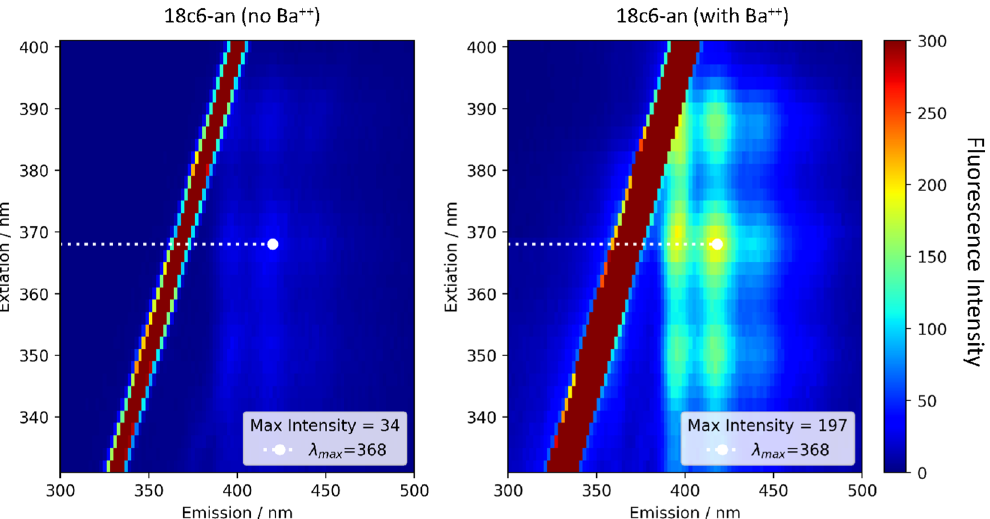
Figure 11. Fluorescence response of 18c6-an shown as a function of emission and excitation. The diagonal band represents directly reflected/scattered